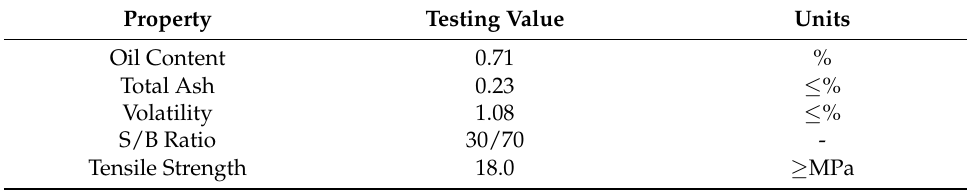
Table 5. Properties of